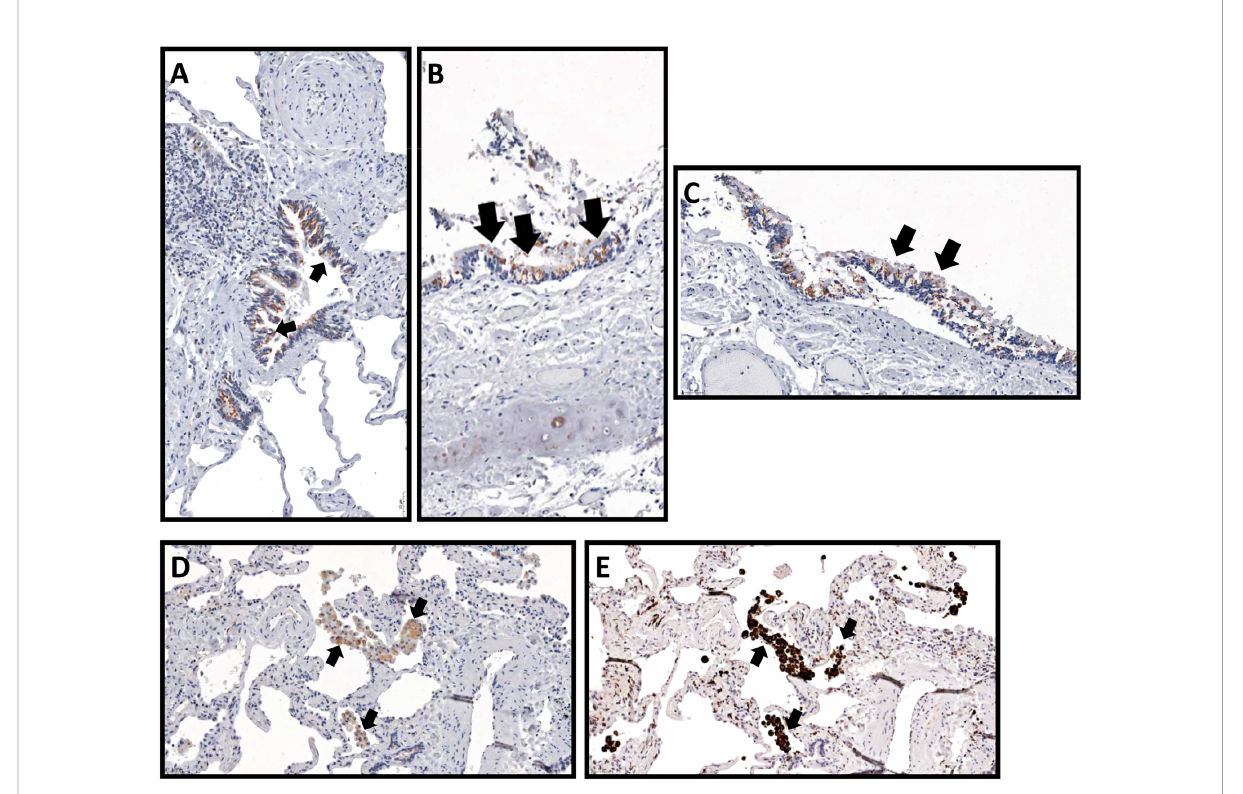
FIGURE 2 CCL21 expression in systemic sclerosis with associated pulmonary arterial hypertension from explanted lung tissue. CCL21 immunohistochemistry demonstrated protein expression (black arrows) from (A-C) airway epithelial cells (20x) and (D) alveolar macrophages (20x), which was con fi rmed by (E) CD68 macrophage marker in a serial cut of the same histopathology